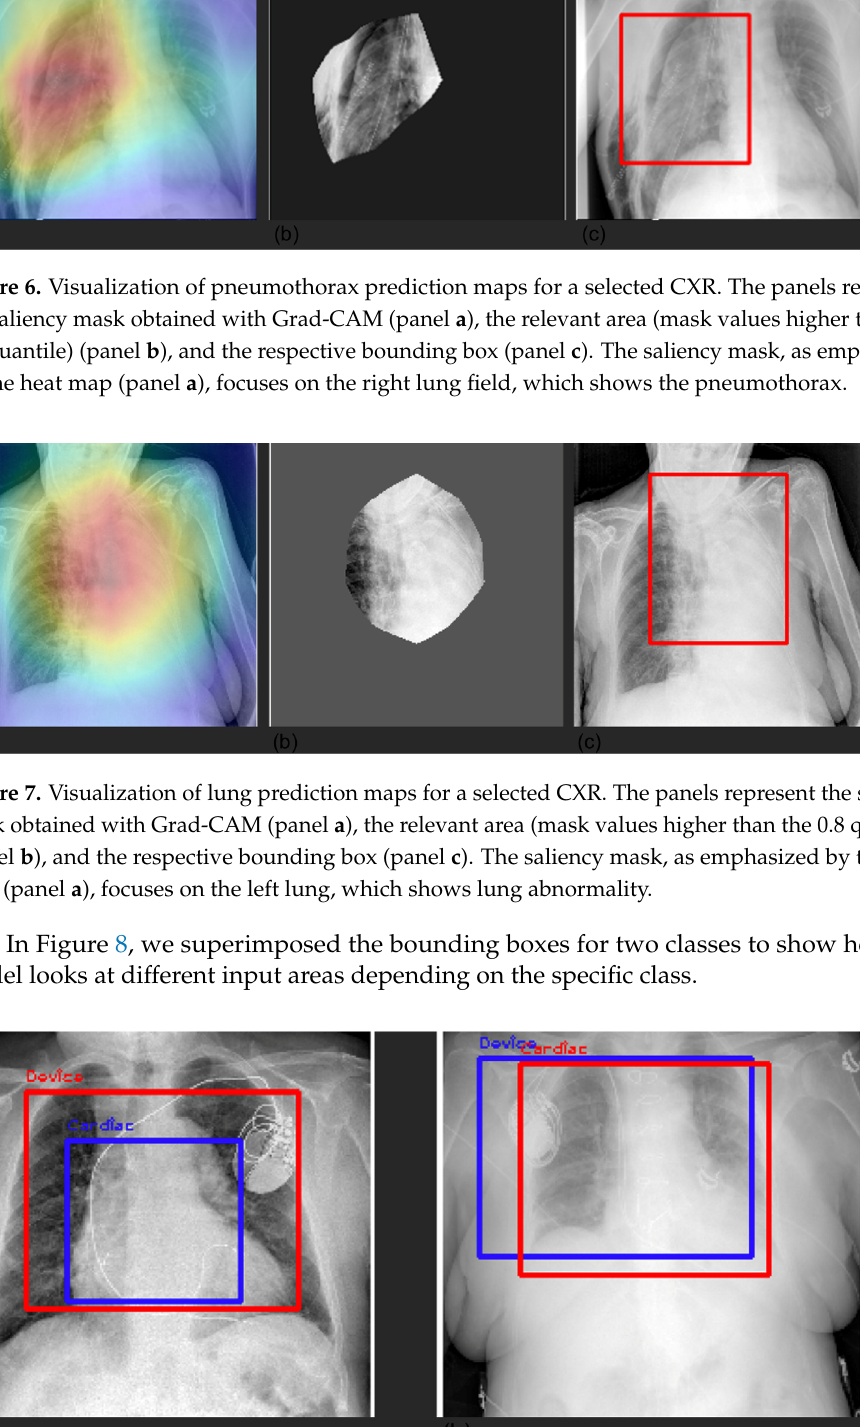
Figure 5. Visualization of device prediction maps for two selected CXRs. The panels represent the saliency mask obtained with Grad-CAM (panels a,d ), the relevant area (mask values higher than the 0.8 quantile) (panels b , e ), and the respective bounding box (panels c , f ). The saliency mask fo- cuses on device (hardware and/or leads), as shown by the heat map (panel a , d ).